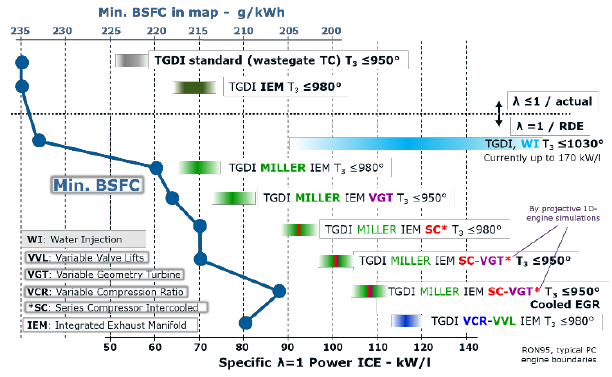
Fig. 13. Measures to increase the stoichiometric power range, RON